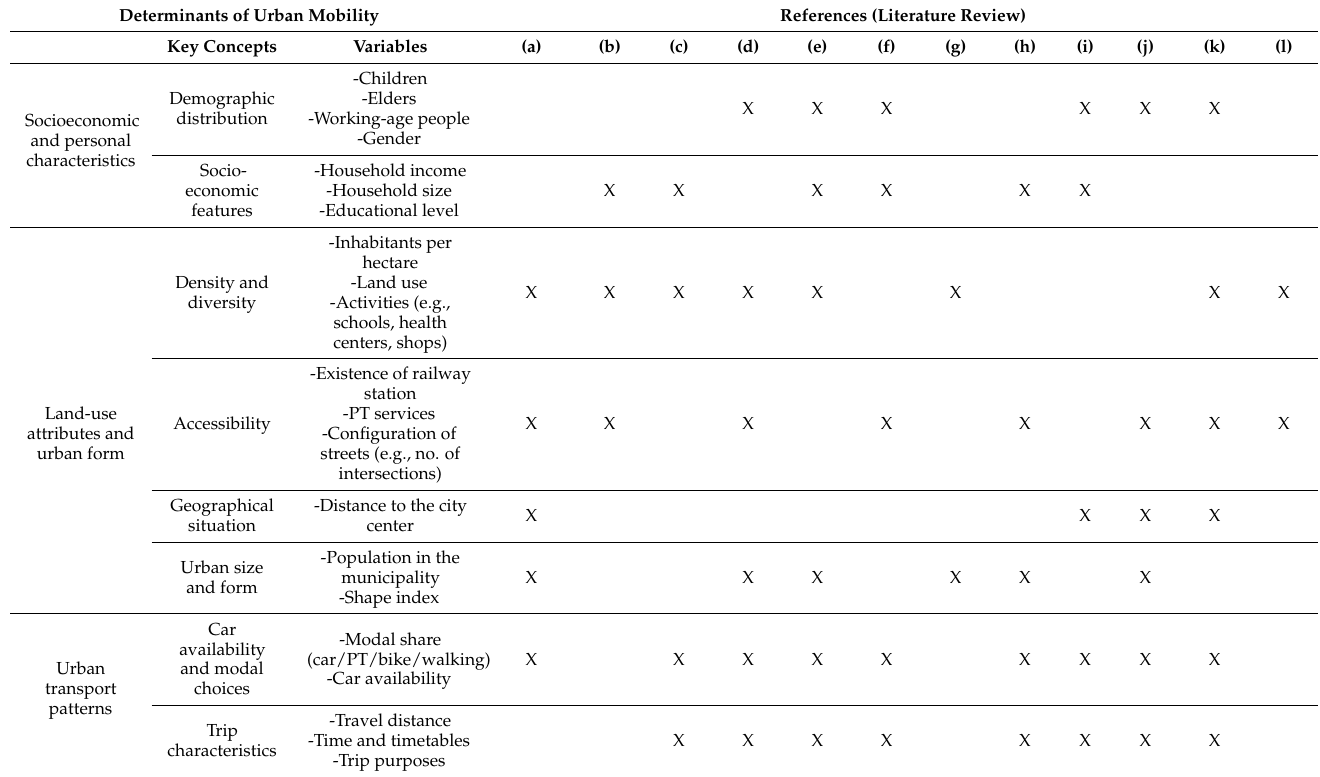
Table 2. Concepts determining urban mobility and related variables (from literature